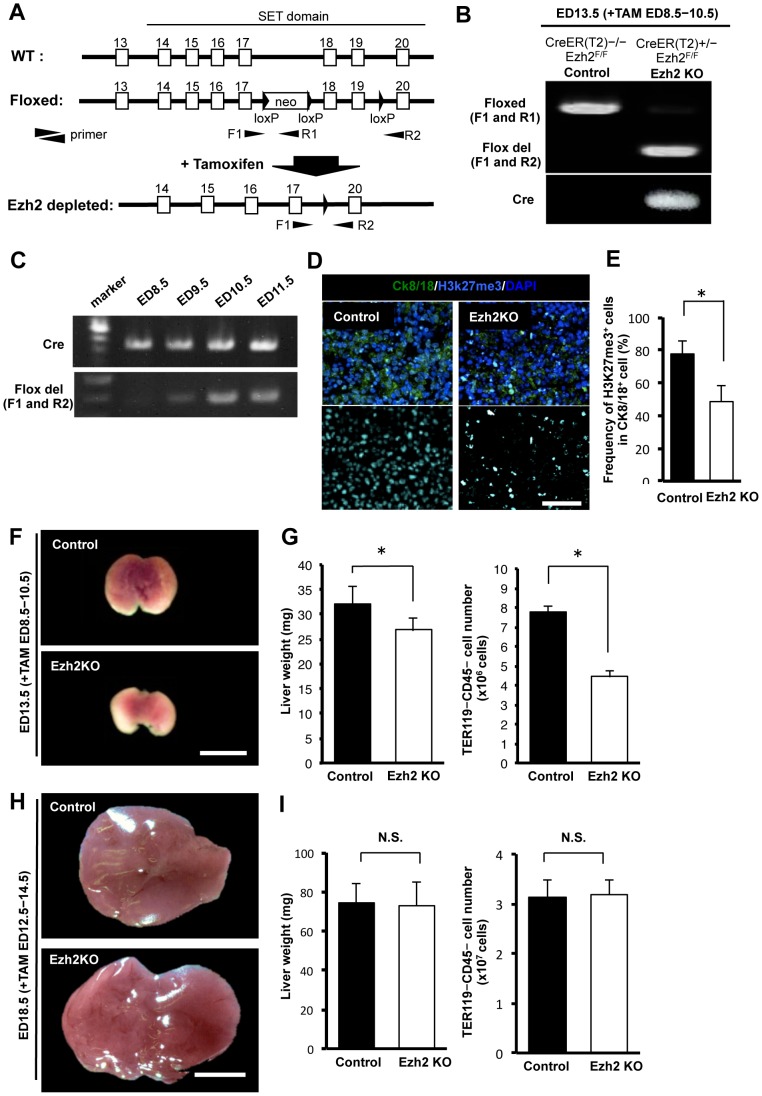
Ezh2 SET domain depletion impaired liver growth.A: Schematic diagram of Ezh2 SET domain KO system. Black triangle, square, and black narrow triangle are indicted as loxP sequence, exon, and primers respectively. F1, R1, and R2 mean forward primer 1, reverse primer 1 and 2. B: Deletion of Ezh2 in liver cells of fetal mouse ED 13.5 obtained from pregnant mouse injected with tamoxifen (TAM) at ED 8.5–10.5 detected by genomic PCR. Cre: Cre allele; Floxed: Floxed Ezh2 allele; and Flox del: floxed Ezh2 allele after removal of exons 18 and 19 by Cre recombinase, respectively. C: Efficiency of deletion of Ezh2 SET domain in fetal mouse at ED 8.5, 9.5, 10.5, and 11.5 (TAM administrated from ED 8.5) by genomic PCR. The bands for Ezh2 SET domain depletion (Flox del) appeared completely clear at ED 10.5. D: Immunofluorescence staining for H3K27me3, CK8/18 (epithelial marker) and DAPI in the liver tissues of control and Ezh2 KO at ED 13.5 after 3 days TAM injection (ED 8.5–10.5). E: frequency of H3K27me3 expressing cells in CK8/18 positive cells at indicated points. Data are mean ± SD (n = 3). P values (asterisks) are from the Mann–Whitney U-test. *P<0.05. F: Macroscopic images of livers in the control (CreER(T2)−/−;Ezh2F/F mouse) and Ezh2 KO (Ezh2 SET domain depleted mouse; Rosa26::CreER(T2)+/−;Ezh2F/F mouse) at ED 13.5 after 3 days TAM injection (ED 8.5–10.5). Scale bar = 100 µm. G: Left panel: liver weight of the control and Ezh2 KO at ED 13.5 (TAM; ED 8.5–10.5). Right panel: Absolute number of TER119− CD45− liver cells per a liver of the control and Ezh2 KO at ED 13.5 (TAM; ED 8.5–10.5). Data are mean ± SD (n = 3). P values (asterisks) are from the Mann–Whitney U-test. *P<0.05. H: Appearance of livers in the control and Ezh2 KO at ED 18.5 after 3 days TAM injection (ED 12.5–14.5). Scale bar = 100 µm. I: Left panel: liver weight of the control and Ezh2 KO at ED 18.5 (TAM; ED 12.5–14.5). Right panel: Absolute number of TER119− CD45− cells per a liver of the control and Ezh2 KO at ED 18.5 (TAM; ED 12.5–14.5). Data are mean ± SD (n = 3). *P<0.05. N.S.; not significant (P>0.05).